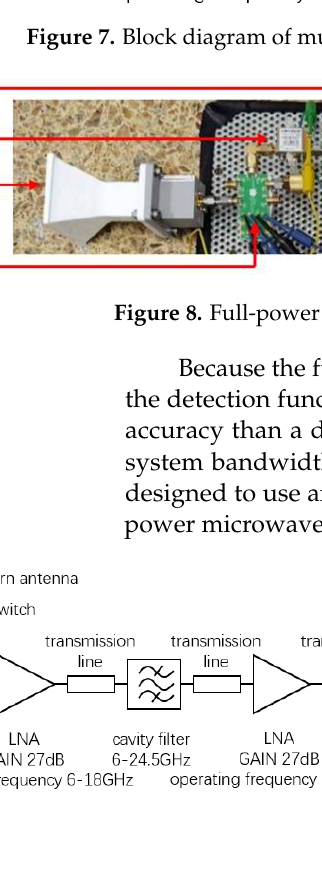
Figure 9. Block diagram of full-power microwave radiometer characteristics.